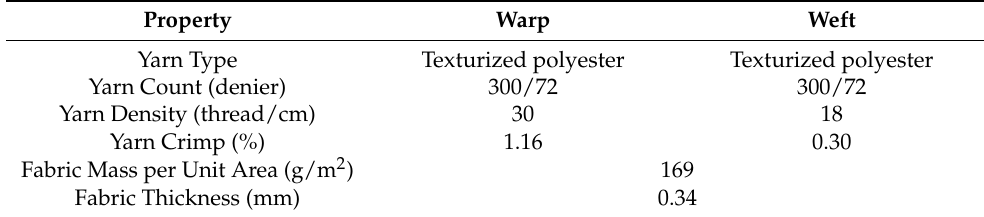
Table 1. Properties of the base